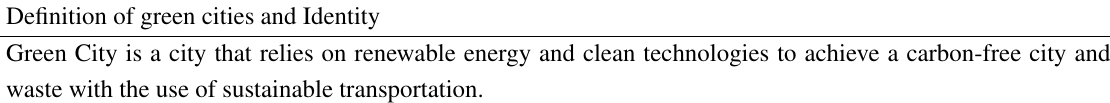
Table 3. Green city - Identity and